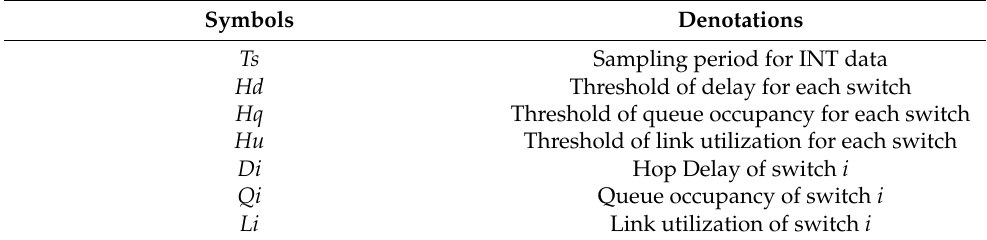
Table 2. Symbols and denotations.